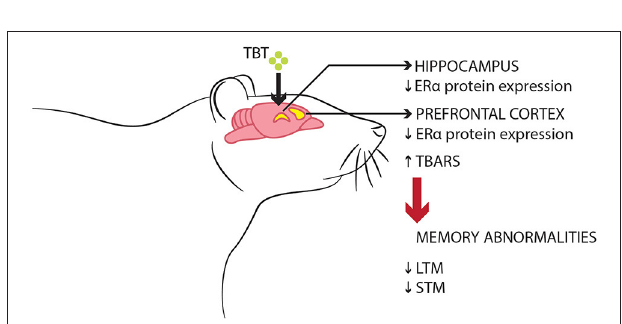
FIGURE 4 | Schematic model of the suggested deleterious effects of TBT on memory function in female mice. TBT exposure for 14 days resulted in recognition memory impairments, disrupted ER α expression, and oxidative stress in brain regions such as the PFC and